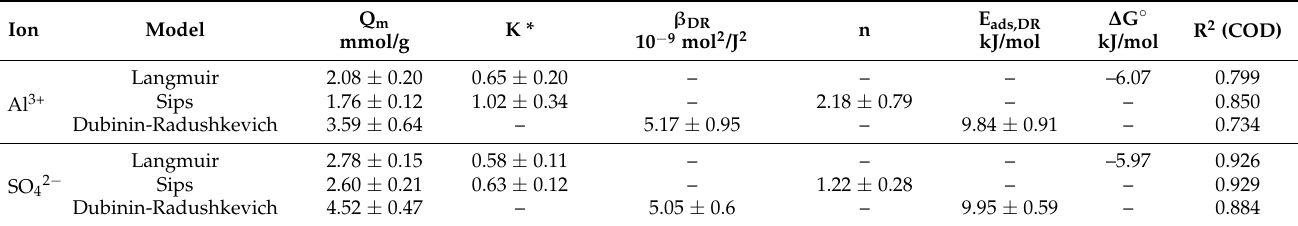
Table 3. Fitting parameters for Langmuir, Sips and Dubinin–Radushkevich isotherm models for adsorption from Al 2 (SO 4 ) 3 solution. Here, Q m is the maximal sorption capacity, K is the equilibrium constant for the respective model, n is the Sips isotherm model exponent, and E ads,DR is the mean free energy of adsorption derived from the Dubinin–Radushkevich model. R 2 corresponds to the coefficient of determination